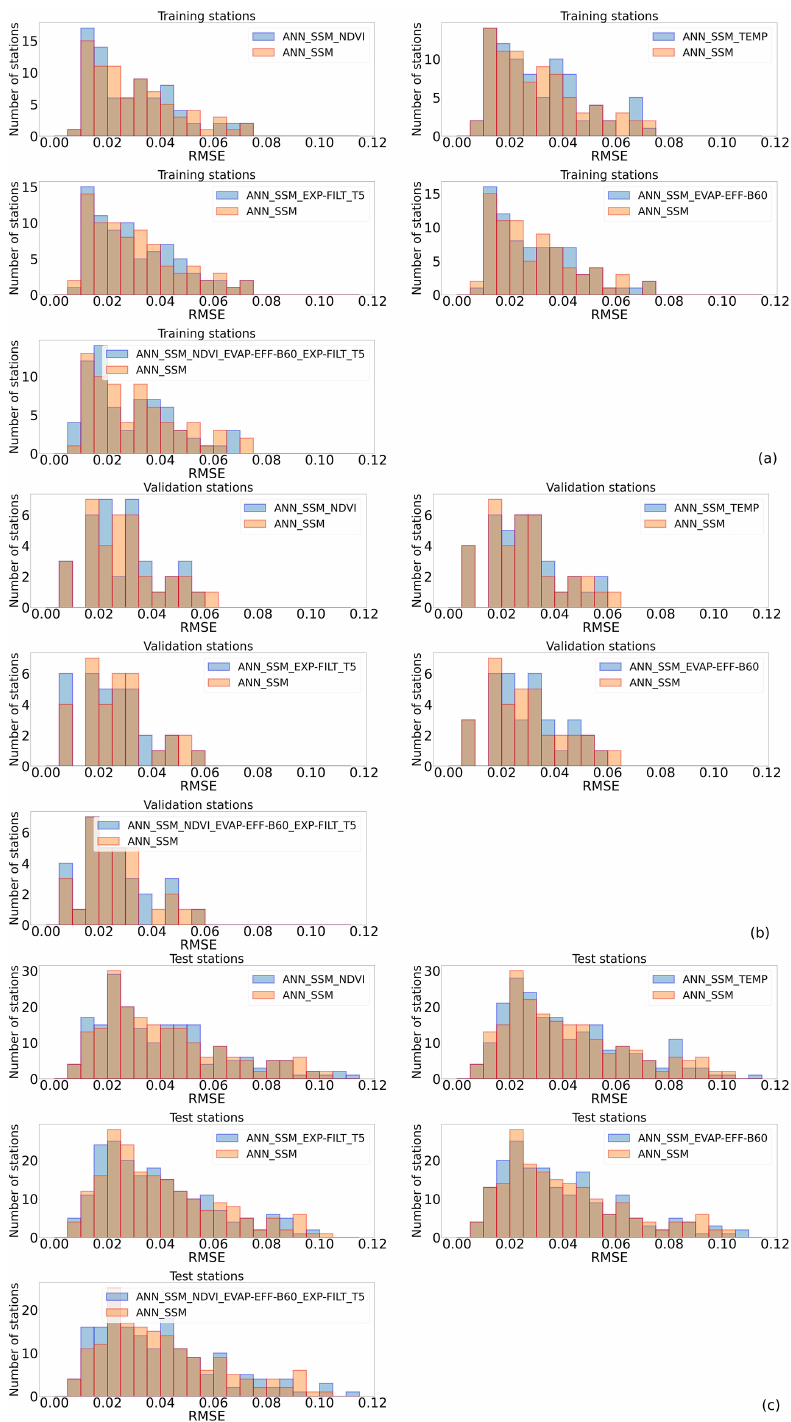
Figure D1. RMSE histograms of all tested ANN models compared to ANN_SSM (a) on training stations, (b) on validation stations and (c) on test